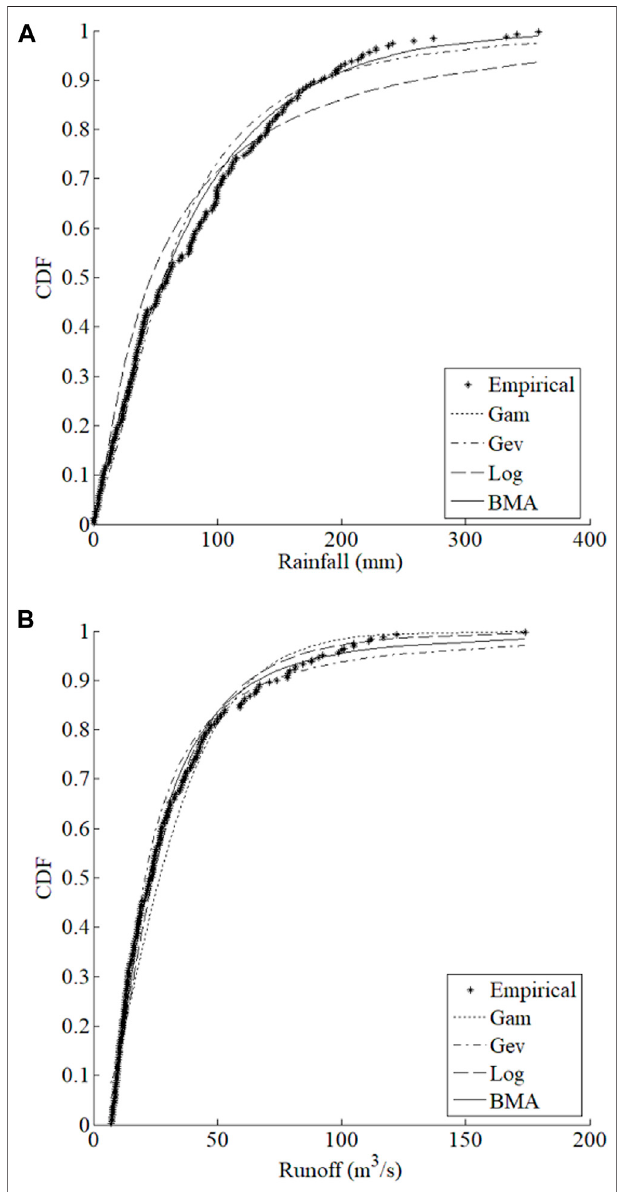
FIGURE 6 | Comparison of the generated and empirical marginal CDF s for mothly rainfall (A) and runoff (B) .